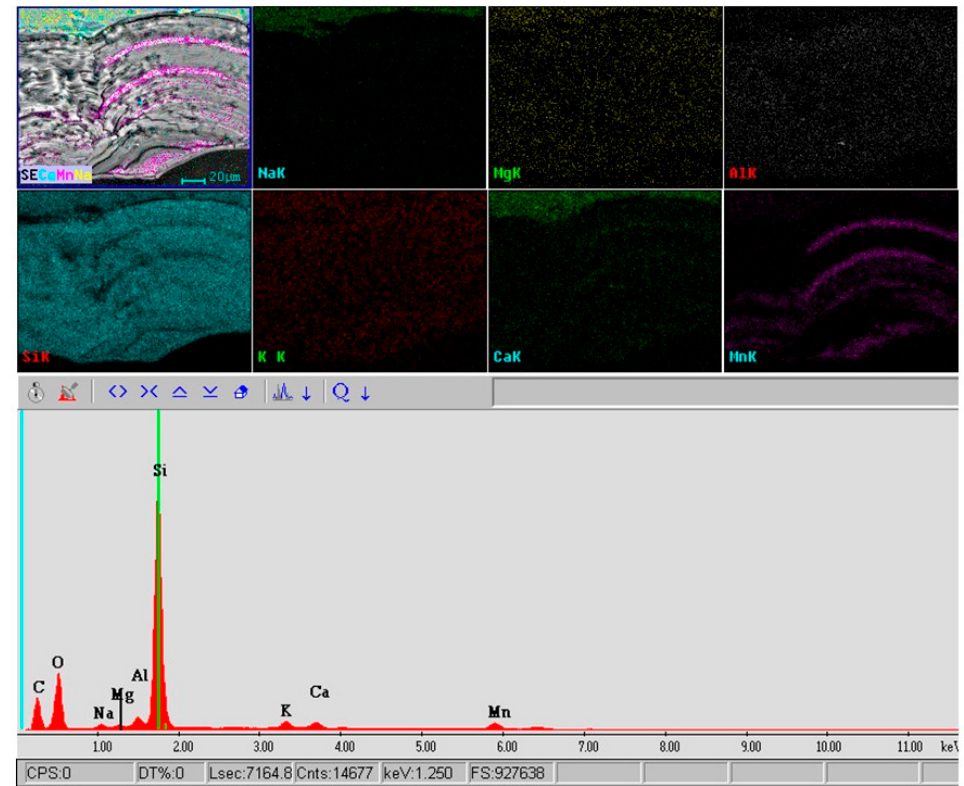
Figure 8. SEM-EDS elemental mapping of the chemical composition (glass fragment KK_d12, cross- section). Scale bar is the same for all subfigures.